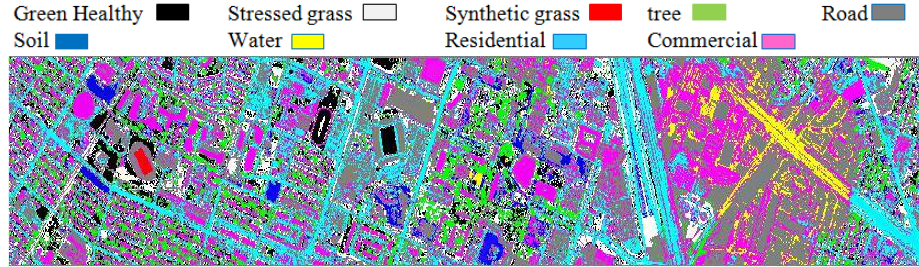
Figure 6. Classification map of proposed SVM based classifier fusion on hyperspectral and LIDAR